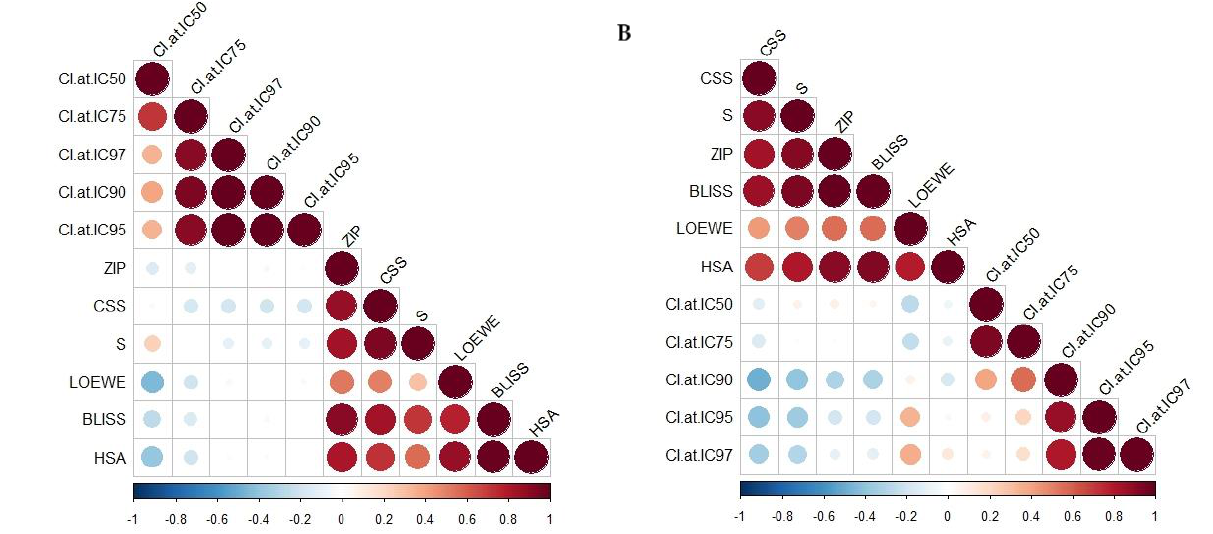
Figure 3. Correlation matrix of different synergy metrics and combination sensitivity scores (CSSs) using ( A ) Pearson and ( B ) Spearman correlation coefficients. CI = combination index derived from Chou–Talalay model; IC = inhibitory concentration killing the corresponding percentage of MCF7 cells. Colour indicates the correlation coefficient along with negative correlations in blue and positive correlations in red, with the size being directly proportional to statistical confidence based on p-